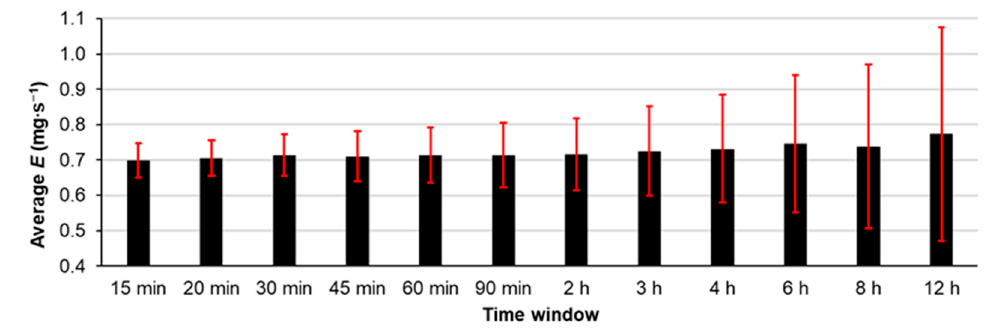
Figure 6. E dependence on the time window width for model data (vertical red lines are standard deviation bars).